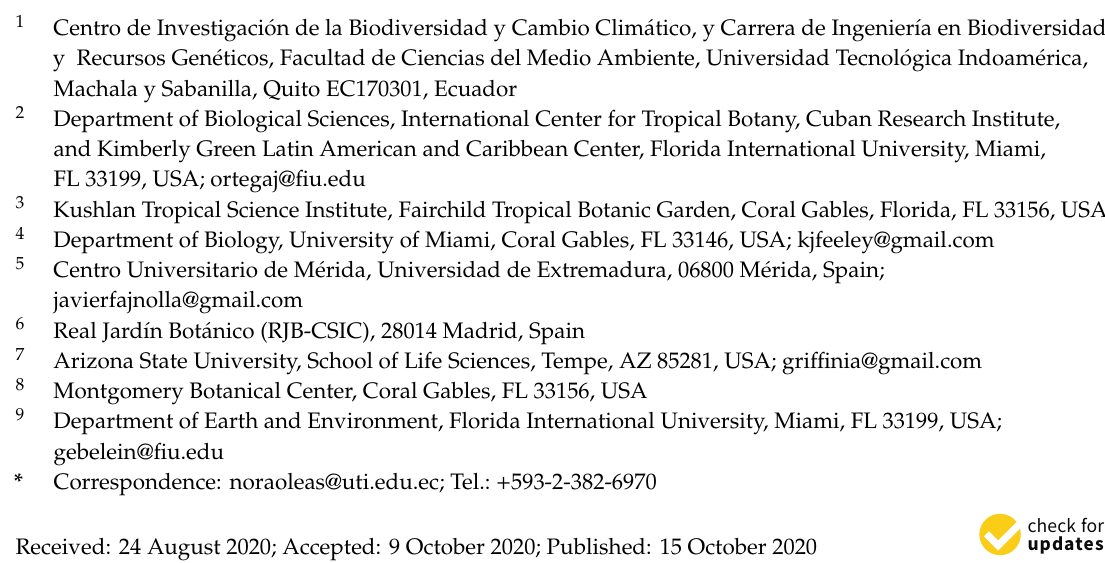
Figure 1. The names of the species were switched between P. schizantha and P. dubia . The correct new Figure 1 is shown below: The above error did not change the results and conclusions of our paper. However, the authors would like to apologize for any inconvenience caused to the readers by this